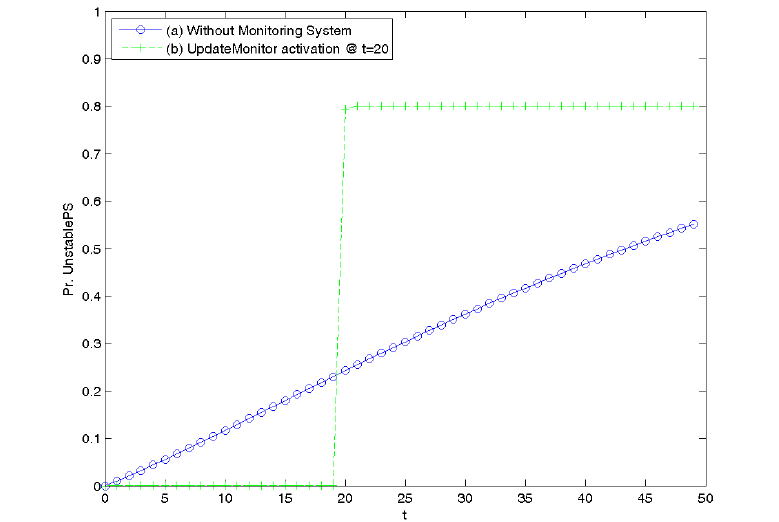
Figure 7. Probability of unstable power system: (a) without security monitoring system; (b) with security monitoring system and the observation that the UPDATE MONITORING / INSTALLED SOFTWARE INTEGRITY CHECK analytic activates at t = 20 (i.e., before time t the analytic is off, from t until the end is on), all other analytics are